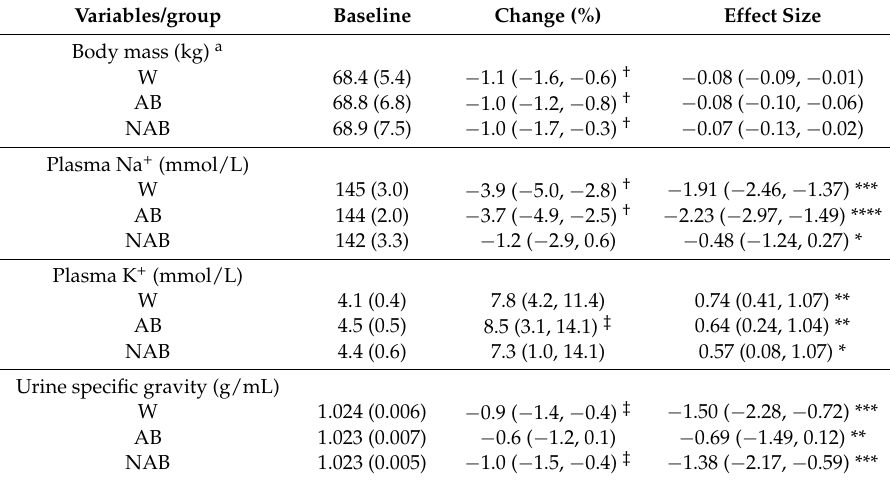
Table 3. Effects (with 90% confidence limits) of water (W), alcoholic beer (AB) or non-alcoholic beer (NAB) intake on body mass and hydroelectrolitic status after 45 min of running at 65% of maximal heart